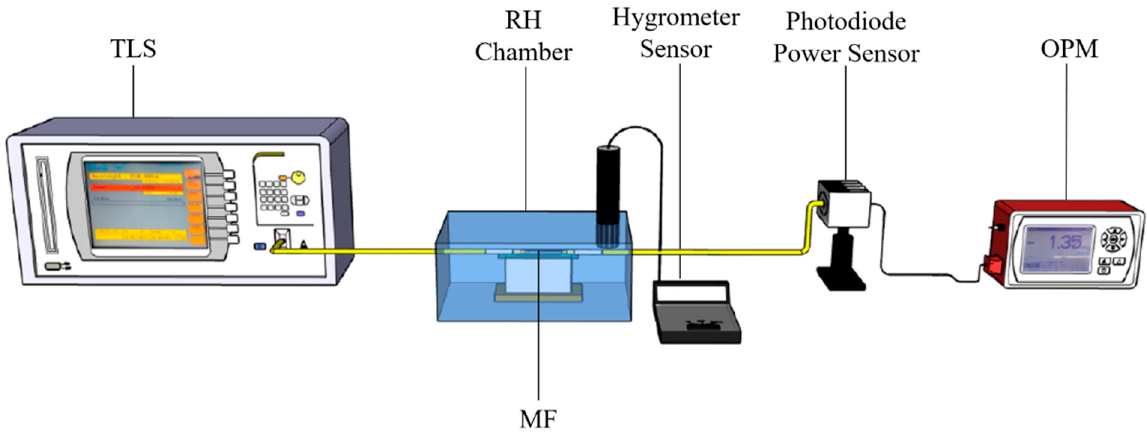
Figure 5. Experimental setup for MF RH sensing.